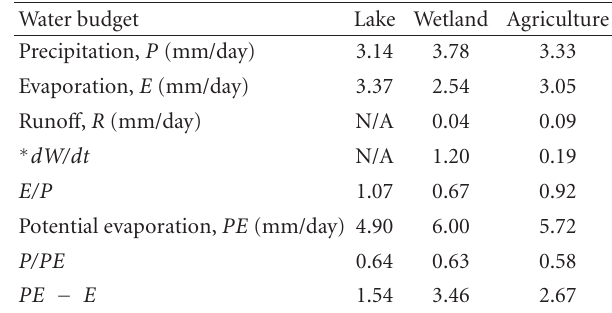
Table 1: Annual mean (1992–2001) water budget for various land uses in Northeast Florida.